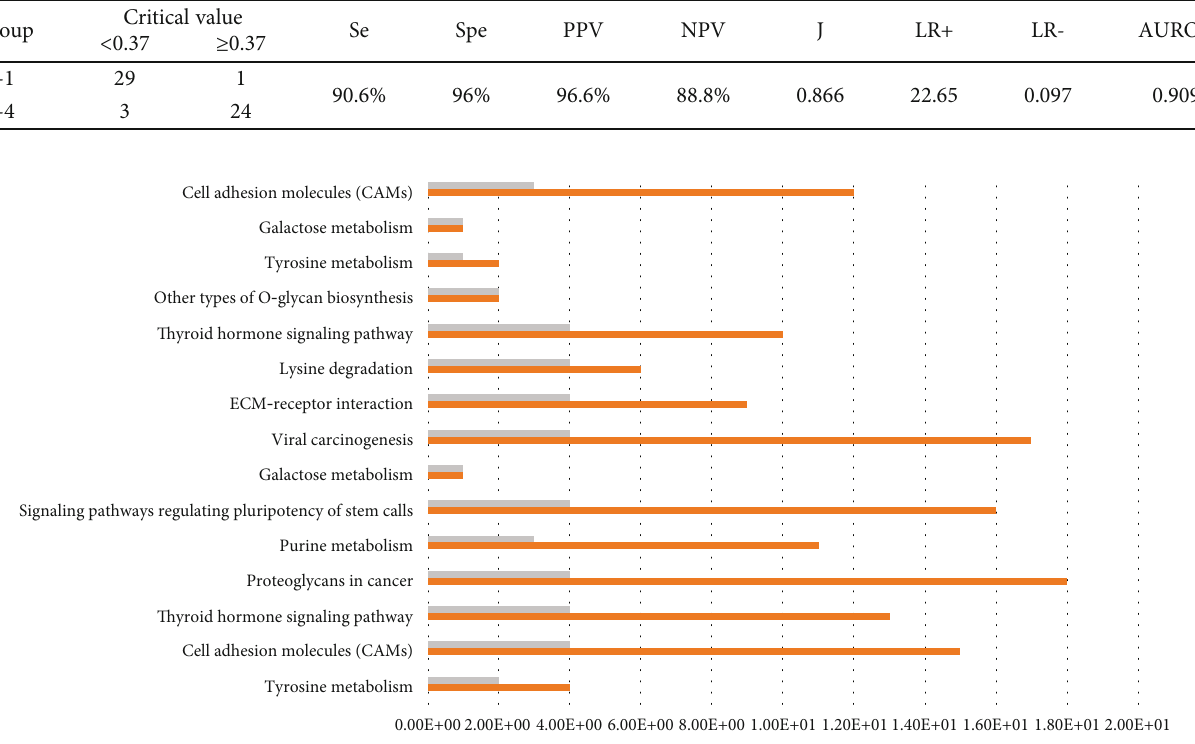
Figure 5: Functional enrichment KEGG pathway analysis of